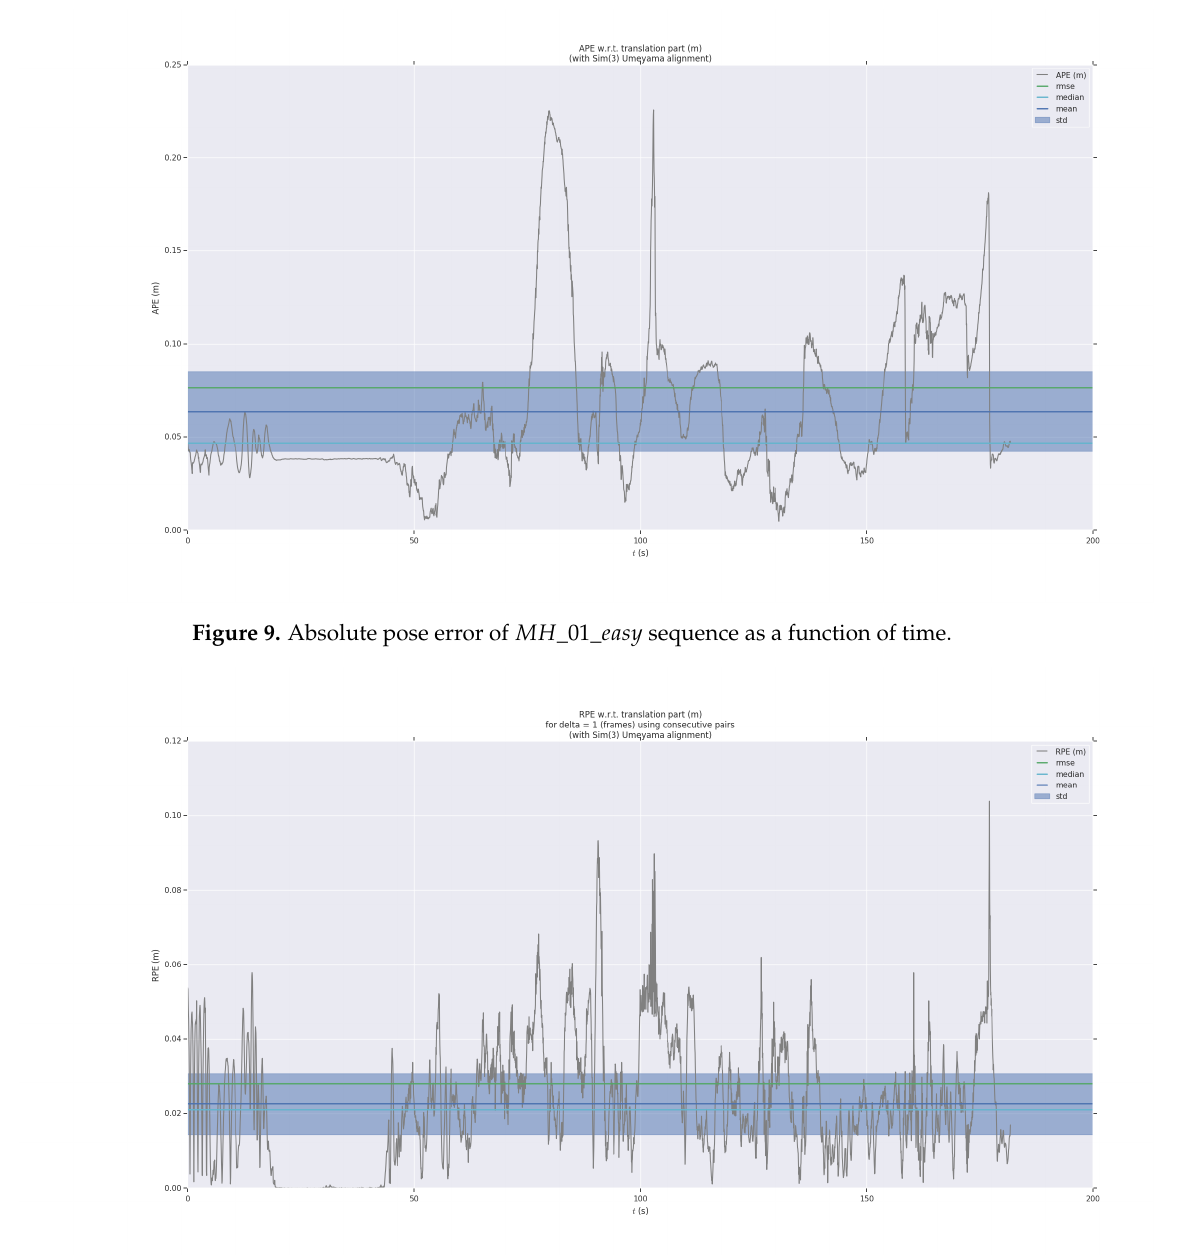
Figure 10. Relative pose error of MH _01_ easy sequence as a function of